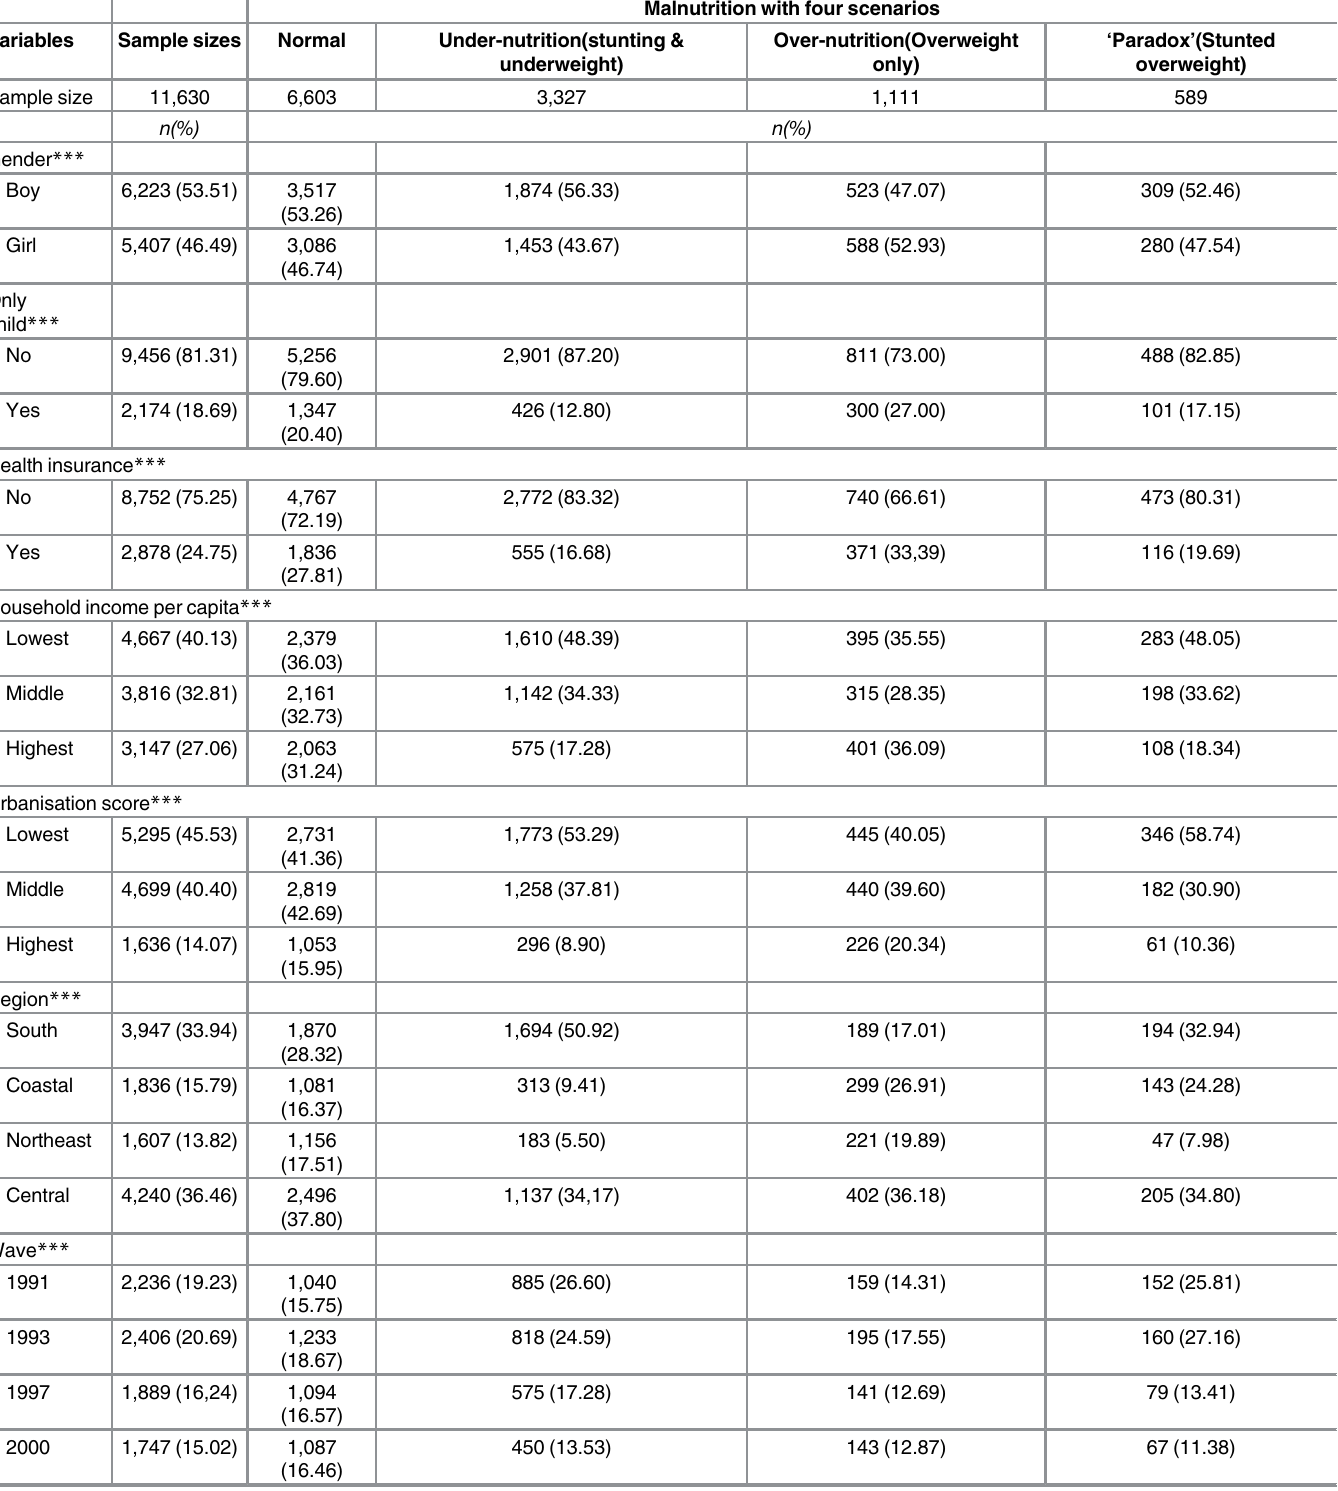
Table 3. Sample size and the distribution of children across four categories of malnutrition by different predictors from the CHNS 1991 –